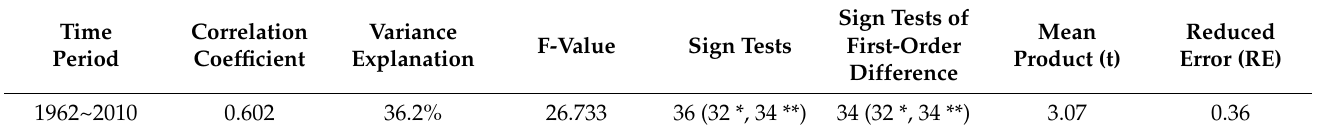
Table 2. Test statistics in leave-one-out cross-validation of the regression